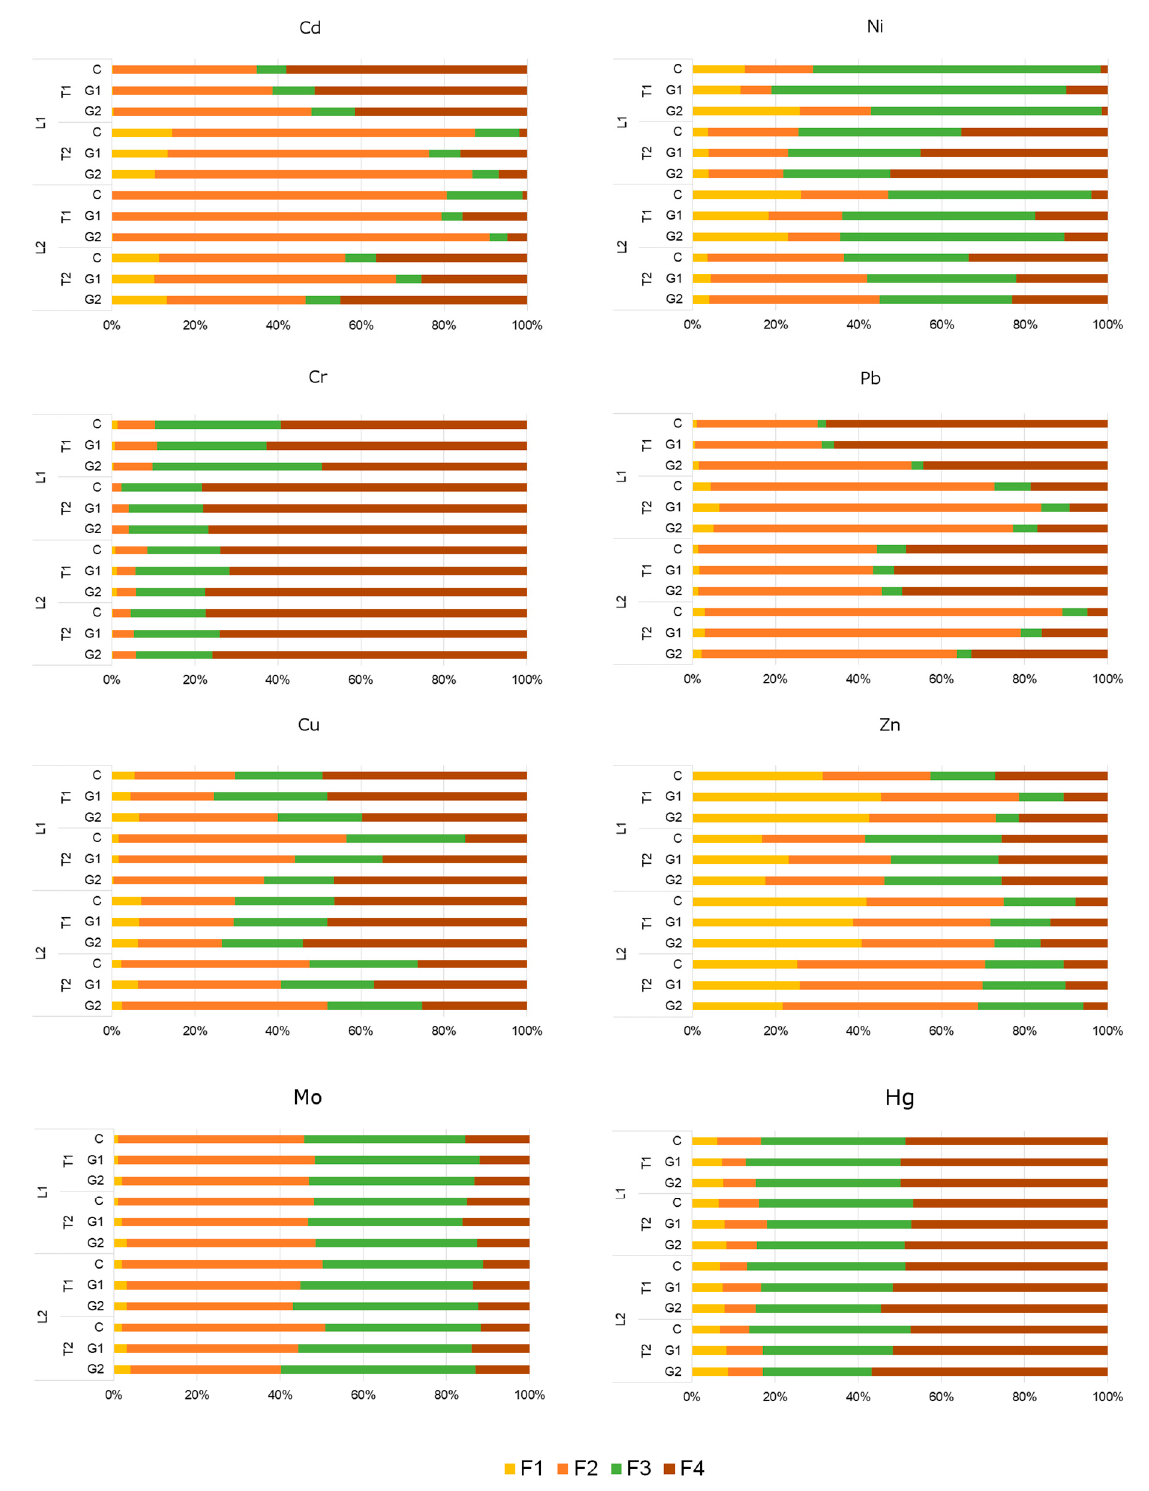
Figure 3. The share of the acid-soluble fraction (F1), fraction related to iron and manganese oxides-reducible fraction (F2), the oxidizable fraction (F3), and the residual fraction (F4) in the total content of Cd, Cr, Cu, Mo, Ni, Pb, Zn, and Hg in soil samples from the control plots (C) and plots fertilized with sewage sludge in a dose of 14.5 t DM/ha (G1) and 29 t DM/ha (G2) in L1 and L2, collected in the first (T1) and second (T2) year of study. In T1, the average Cd content in soil was from 0.09 mg/kg DM to 0.20 mg/kg DM, while in T2, it increased to the values from 0.21 mg/kg DM to 0.41 mg/kg DM. It was found